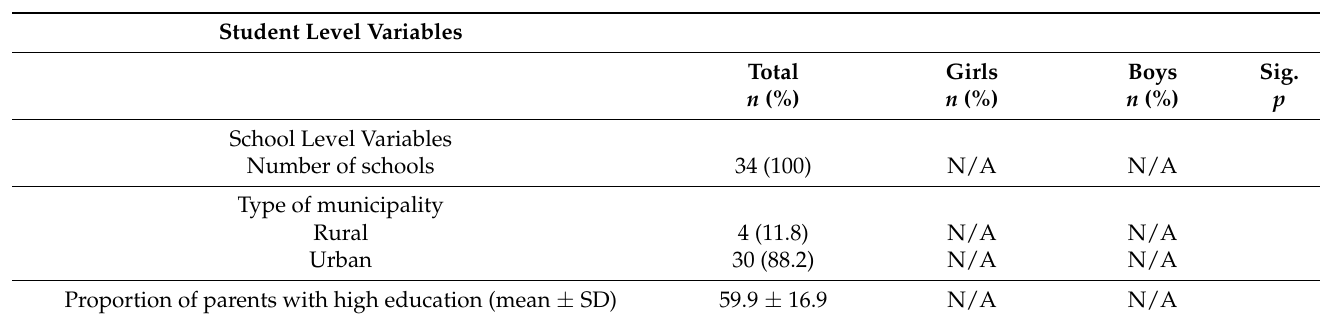
* According to the International Obesity Task Force age-standardised cut-offs from 2012. Sig: Significant. Of the whole sample, 903 (79%) of the participants had valid accelerometer registrations for a whole week and 1054 (95%) of the participants had valid registrations for school days. Slightly more girls than boys had valid registrations ( p < 0.001 for the whole week and p = 0.014 for the school week) but no statistically significant differences were found in parental education and BMI. Approximately one-third of the sample met the recommendation of 60 min MVPA per day in this age group (Table 1). The proportion was significantly lower for girls than for boys (25% versus 37%). During school time, girls had less minutes in MVPA compared to boys ( p < 0.001) but there was no difference between sexes during leisure time ( p = 0.145), see Figure 2. Girls were more sedentary during school time ( p < 0.001) and had lower LIPA compared to boys ( p < 0.001). However, during leisure time, girls had both higher levels of LIPA ( p < 0.001) and sedentary time ( p = 0.01) than boys. The variation of MVPA between schools is depicted in Figure 3, where the level of MVPA ranged from 15 to 44 min across schools.